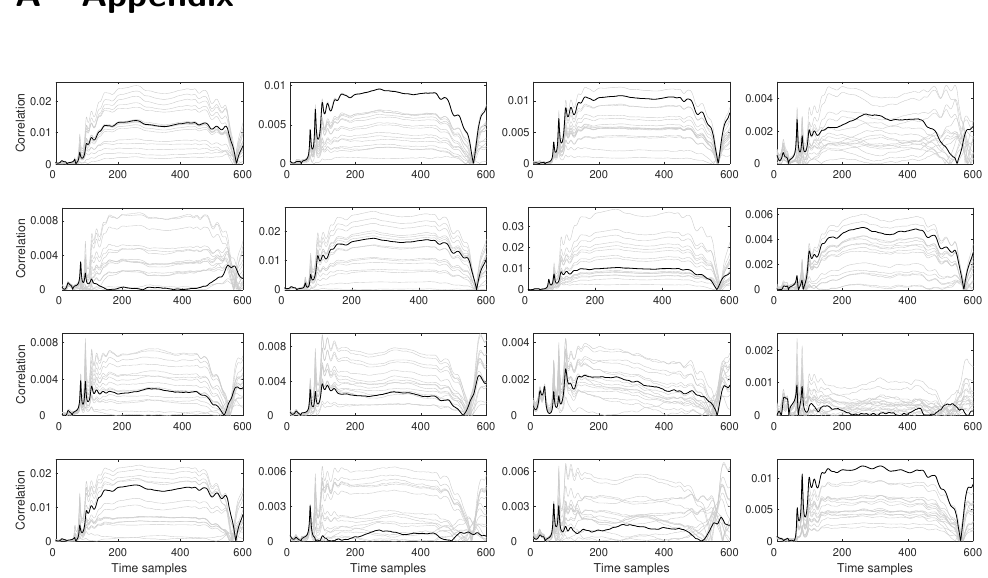
Figure 13: CPA attack on unrolled PRINCE using 100 million traces when the plaintext is reset to a random state between encryptions. Results for all 16 key nibbles are presented and the power model is the Hamming weight of the first-round Sbox output.